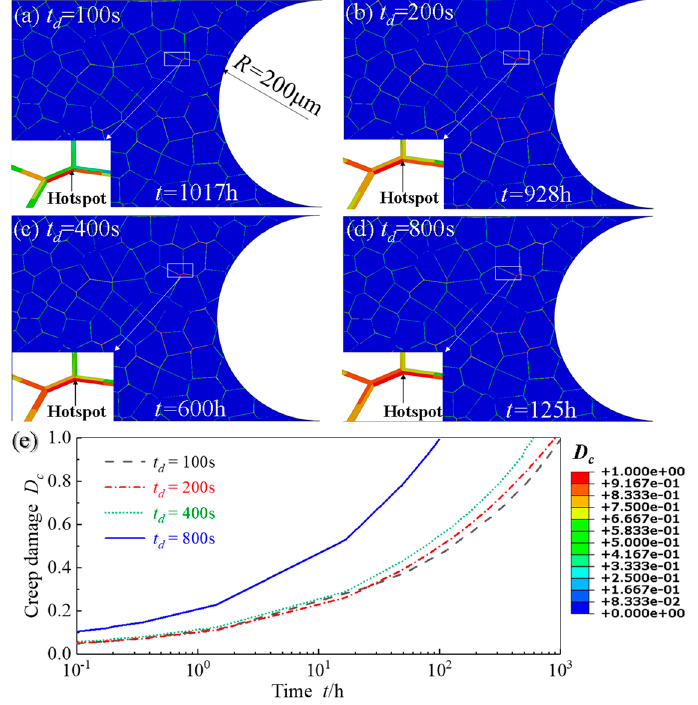
Figure 12. Distribution of creep damage distribution of notch specimens for four different holding time: ( a ) t d = 100 s; ( b ) t d = 200 s; ( c ) t d = 400 s; ( d ) t d = 800 s and ( e ) the evolution curves of creep damage D c of hotsopts from ( a – d ).